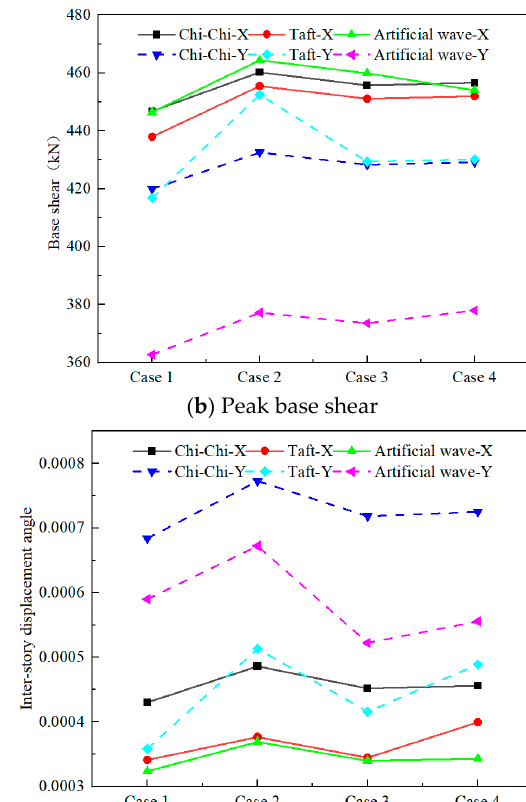
Figure 9. Elevator installation location plans(mm).